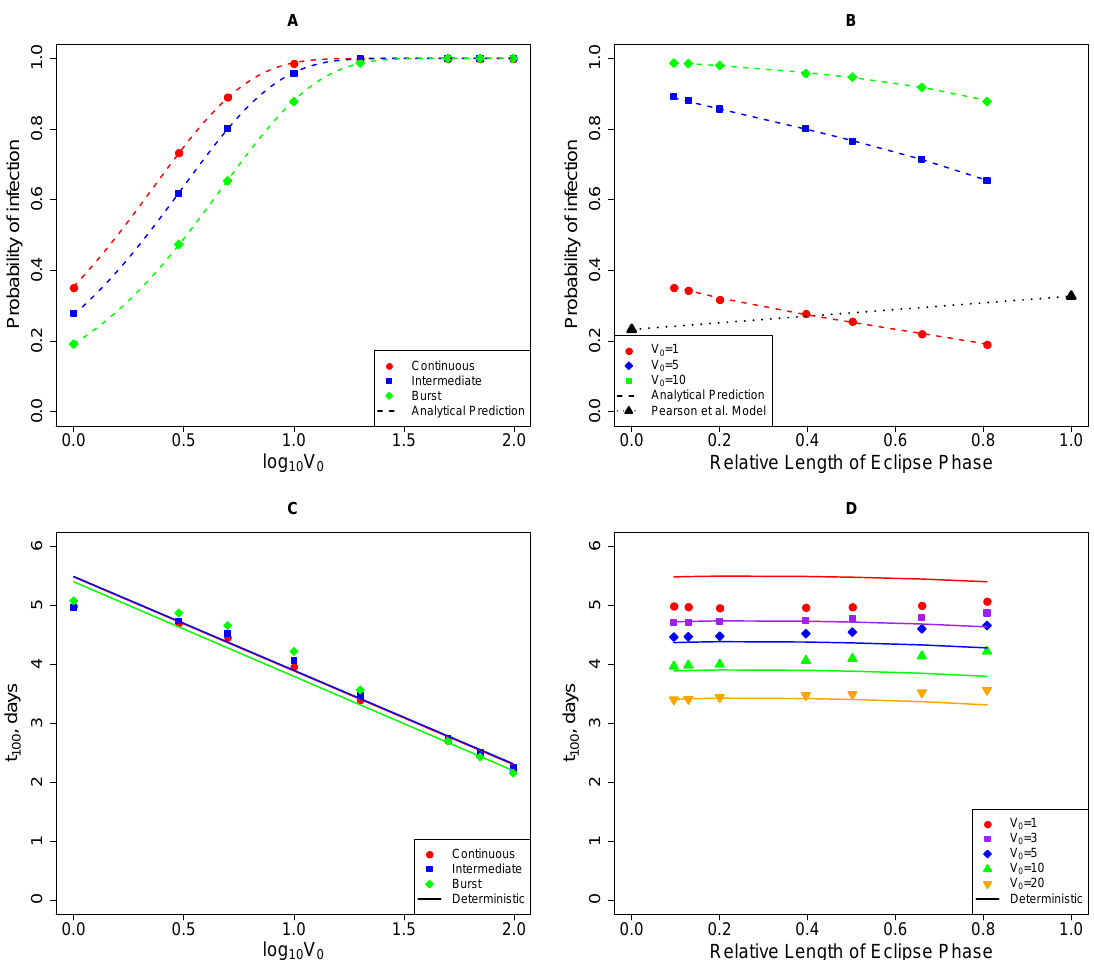
Figure 4. Changes in the probability of established infection ( p , panels A and C) and inf the time to 100 infectious viruses ( t , panels C and D) with the initial number of viruses 100 ( V ) and the relative duration of the eclipse phase ( T , Equation (4)) as predicted by 0 m stochastic and deterministic simulations of the mathematical model (Equations (1)–(3)). In panels A and B, points represent values from stochastic simulations and dashed lines are analytical predictions (Equations (13)). Black triangles in panel B show the probability of infection for budding and bursting modes of virus production by infected cells as calculated in Pearson et al. [22]. In panels C and D, points are the results from the simulations and solid lines are the predictions from deterministic solutions of the model. Parameters for the simulations are given in Table 1 with values for the maturation rate m varied between 0 . 7 day − 1 and 5 day − 1 with δ being adjusted to satisfy constrains as described in the I